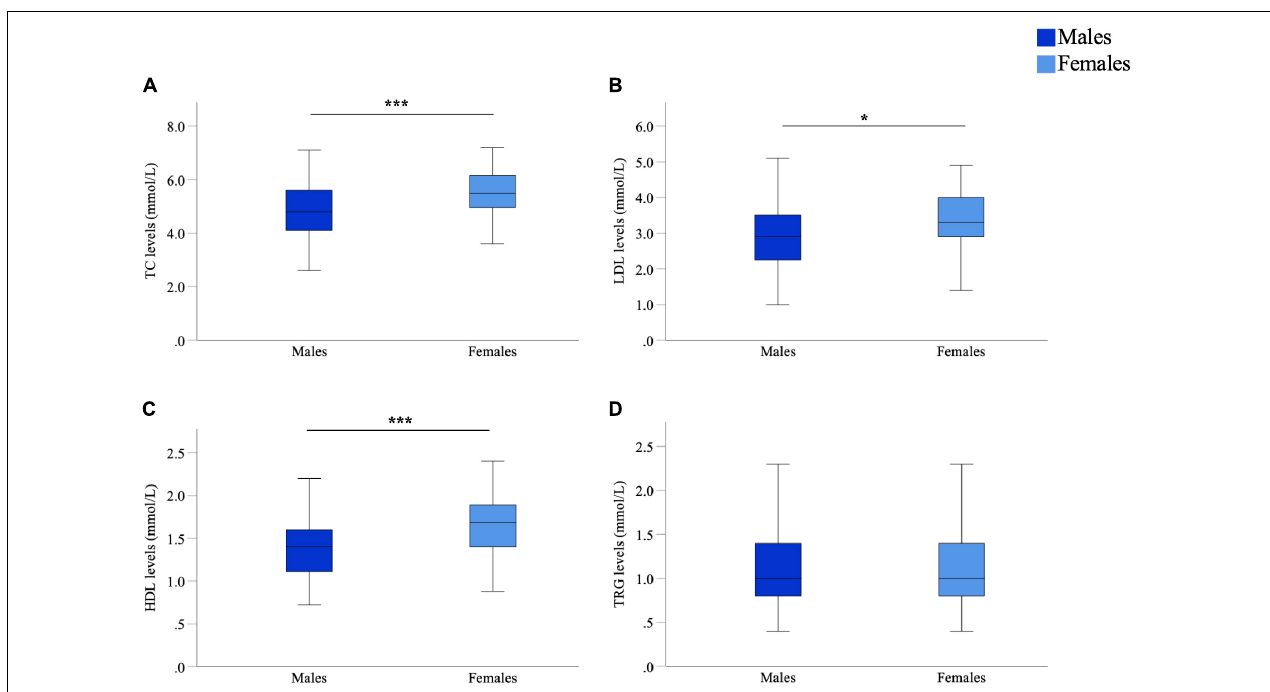
FIGURE 1 | Comparison of serum marker levels between males and females in a Parkinson’s disease (PD) cohort. Mean TC (A) , LDL (B) , and HDL (C) levels were significantly higher in females than males, mean TRG (D) levels were not significantly different. Data are presented as mean ± SEM. * p < 0.05; *** p < 0.001. TC, total cholesterol; LDL, low-density lipoprotein; HDL, high-density lipoprotein; TRG,